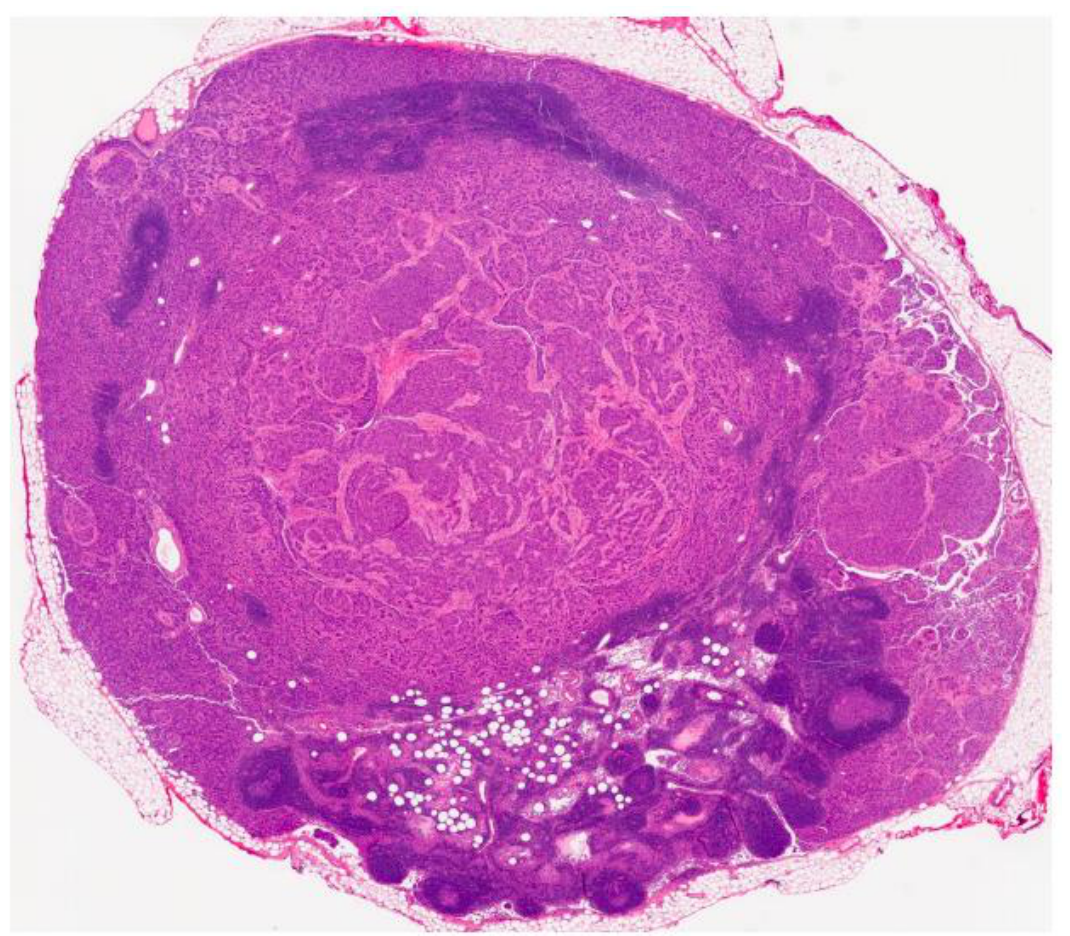
Figure 3. HE stains showing GIST lymph node metastasis.